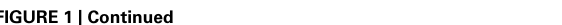
FIGURE 1 | Continued Schematic representation of selected members of genetically encoded indicators of neural activity (GINA). (A–C) Calcium indicators. (A) GCaMP6 consists of circularly permuted green fluorescent protein (cpGFP) inserted between calmodulin (CaM) and an M13 peptide. Upon calcium binding, conformational changes in the CaM–M13 complex induce fluorescence changes in the circularly permuted enhanced green fluorescent protein (cpEGFP). (B) YC-Nano contains CaM–M13 complex sandwiched between the donor FP (ECFP) to the acceptor FP (cp173Venus). Upon calcium binding, conformational changes of CaM–M13 complex increases Förster resonance energy transfer (FRET) between the FP pair. The result is an increase in the ratio of the fluorescence in the yellow to blue channels. (C) Likewise,Twitch-2B increases FRET upon calcium being bound by its calcium sensitive domain, tsTnC. (D–F) GINAs reporting synaptic activity. (D) SynaptopHluorin consists of a ecliptic pHluorin FP fused to the C-terminus of the vesicular protein.Vesicular release places the FP in the low pH environment of the extracellular space, which leads to the deprotonation of the fluorophore and increases pHluorin fluorescence. (E) SuperGluSnFR is a linear fusion of CFP, the Escherichia coli glutamate binding domain, GltI, and mCitrine. Upon glutamate binding, the conformational changes of GltI result in FRET between CFP to mCitrine. (F) iGluSnFR contains a cpGFP fused to the glutamate binding domain.The conformation changes of Gltl induced upon glutamate binding results in deprotonation and increased fluorescence of cpGFP. (G–J) Genetically encoded voltage indicators. (G) Upon membrane depolarization, the voltage-sensing domain of Ci-VSP enters its activated state.The FPs of voltage sensitive fluorescent protein (VSFP)-Butterfly 1.2 are thus drawn into close proximity to one another, increasing FRET. (H) The opsin-based MacQ-mCitrine reduces fluorescence output upon membrane depolarization.This effect is driven by enhanced FRET from the mCitrine FP to the weakly fluorescent retinal caused by a shift in the cofactor absorption spectrum upon protonation of the Schiff base. (I) ArcLight consists of Ci-VSD and super ecliptic pHluorin carrying the point mutation A227D. Depolarization of the membrane results in a decrease in the fluorescence output of the pHluorin, but the mechanism of this change remains elusive. (J) ASAP-1 contains cpGFP fused into an extracellular linker (S3–S4 linker) of the Gag-VSP voltage sensitive domain. Depolarization quenches the fluorescence of the